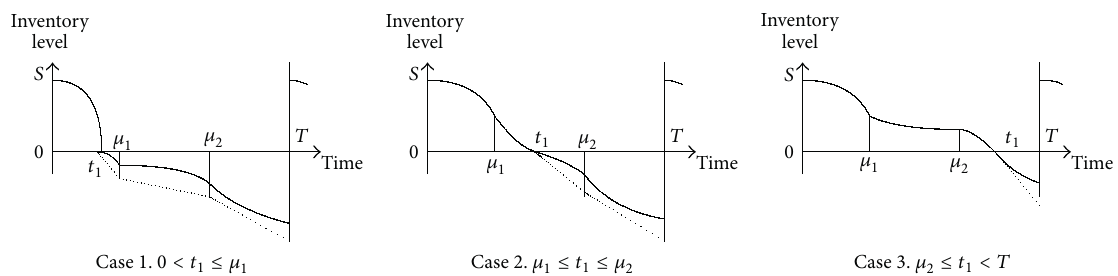
Figure 1: Graphical representation of inventory level over the